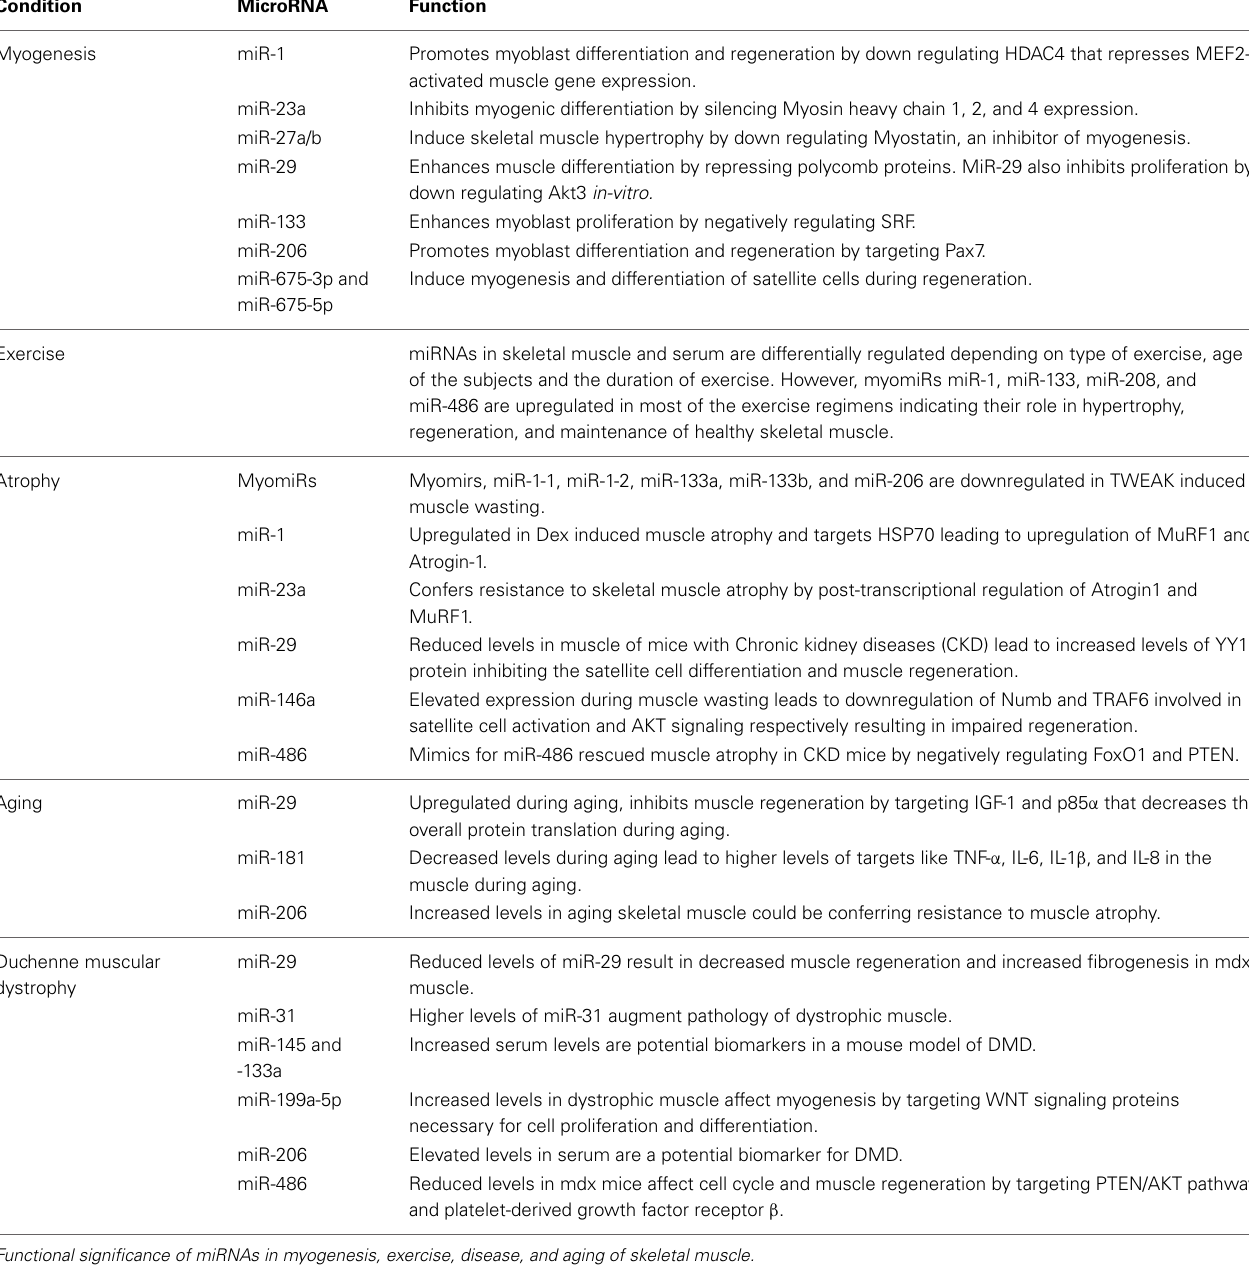
Table 1 | Over view of miRNAs differentially regulated in myogenesis, exercise, atrophy, aging, and Duchenne muscular dystrophy and their functional roles in regulation, maintenance, and pathology of skeletal